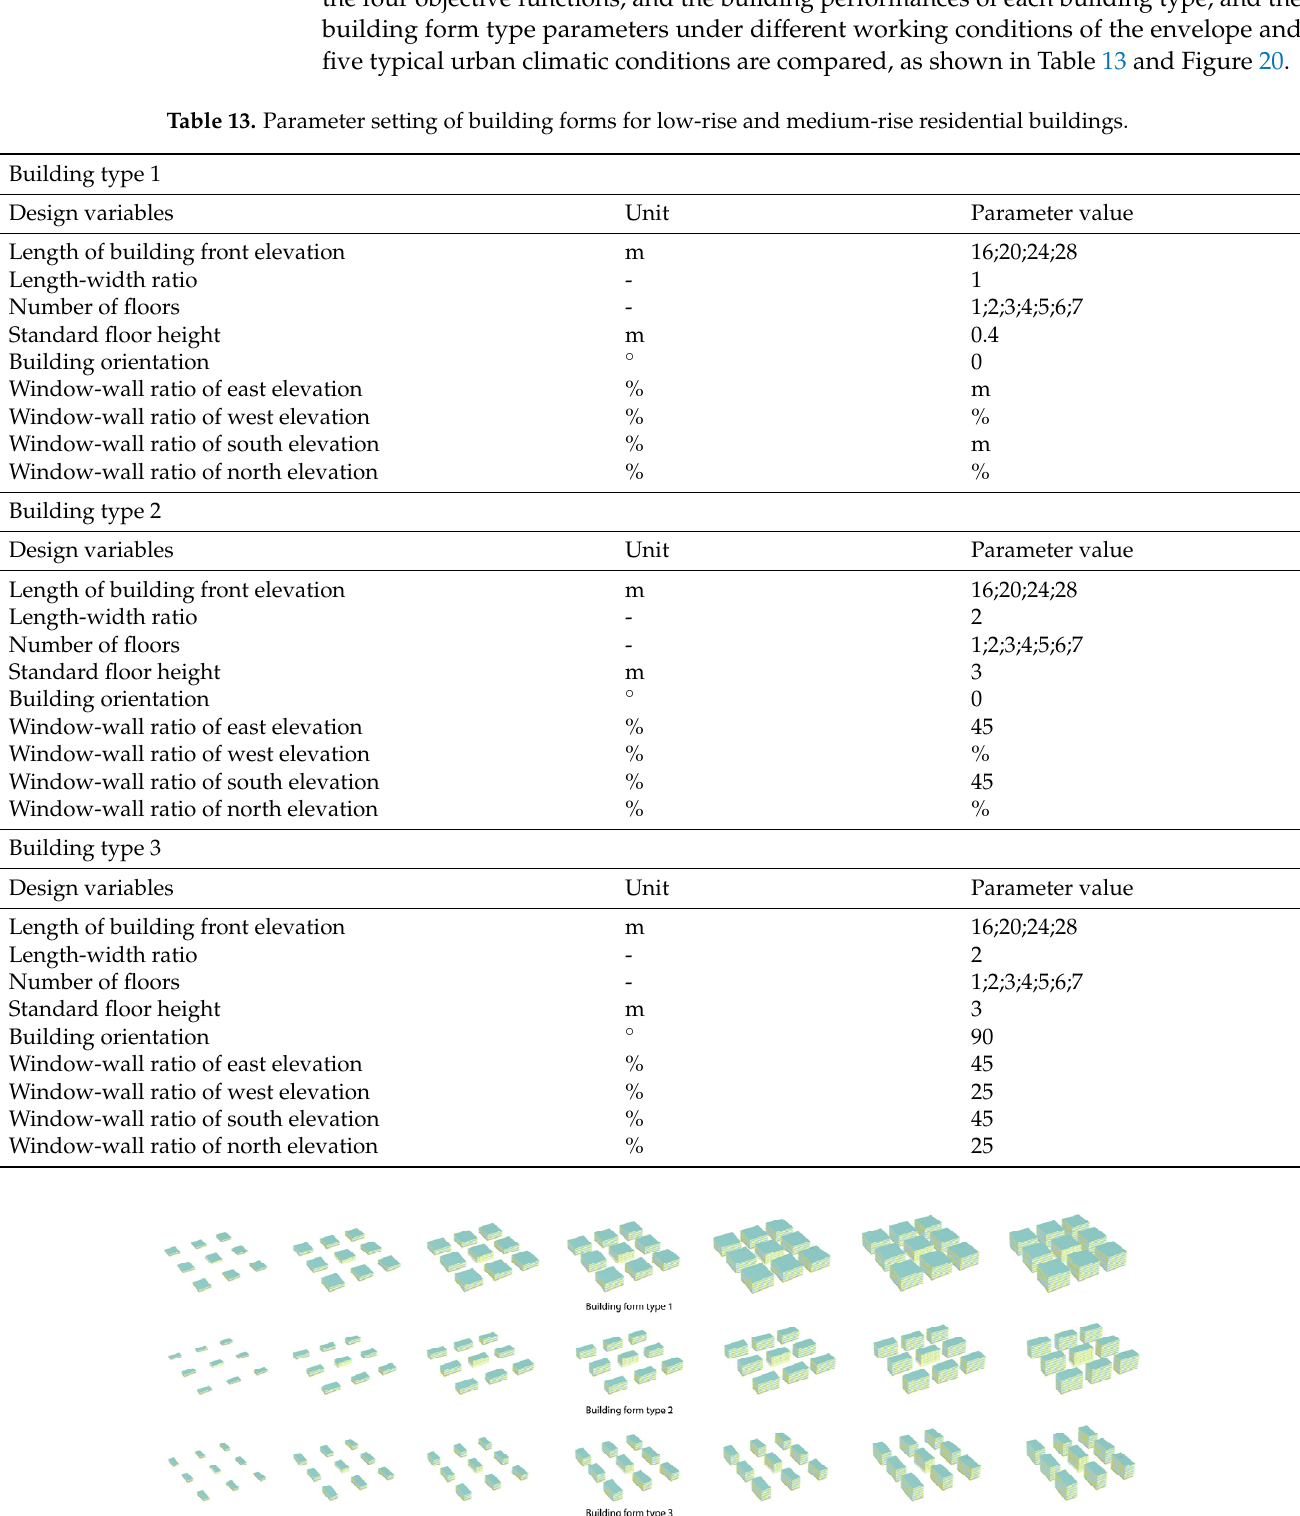
Figure 20. Three changes in building form